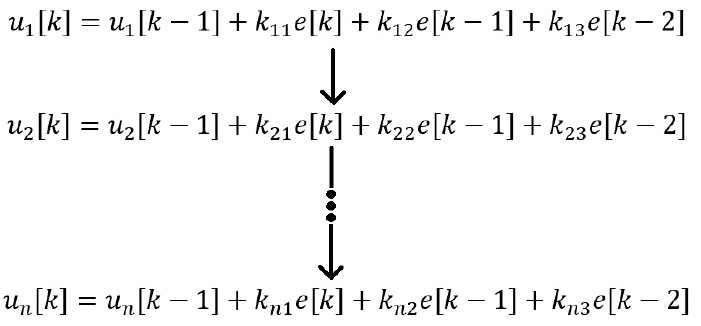
Figure 4. Multiple PID controller equation for microprocessor.